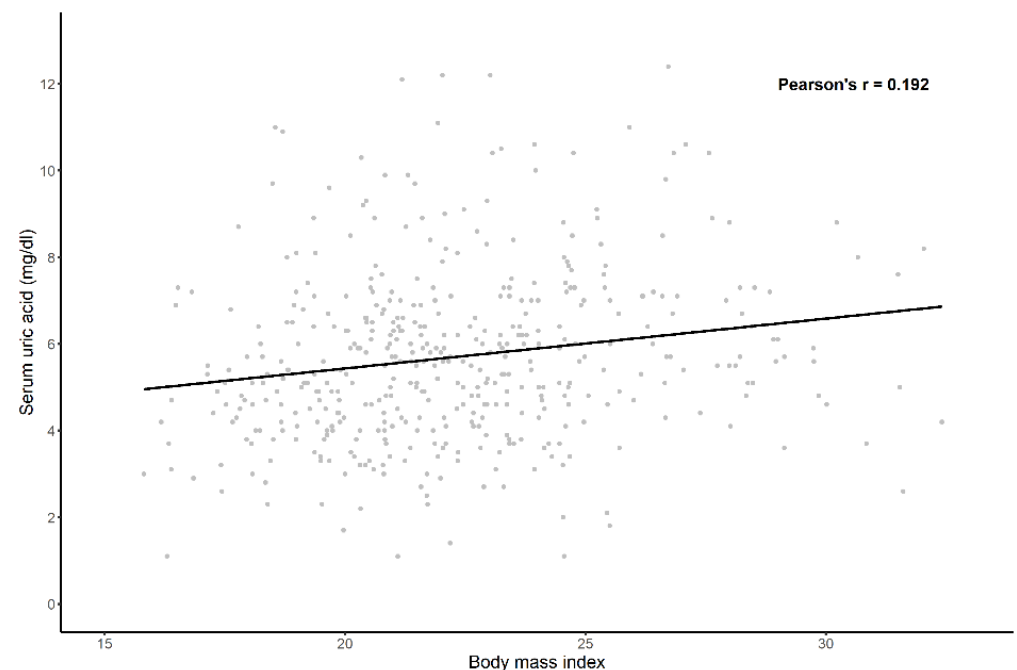
Figure 3. Association between body mass index and serum uric acid. Body mass index and serum uric acid showed positive correlation.